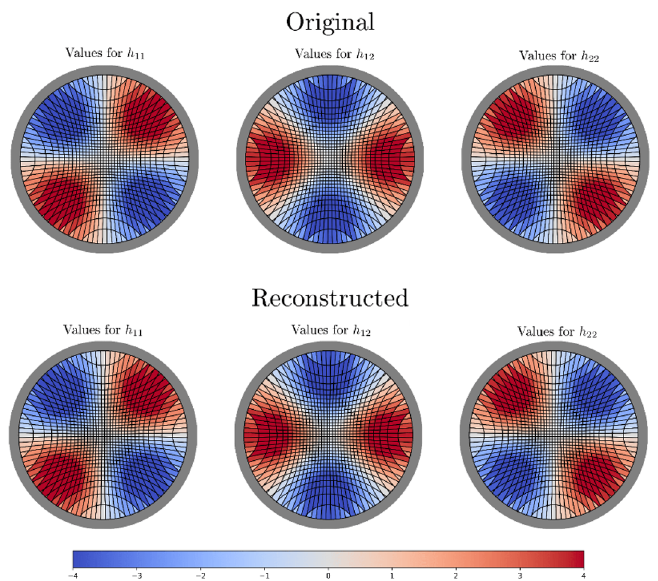
Figure 16. Top: Original bulk data generated with h 0 ( x, y ) = xy and h | C ( θ ) = sin(2 θ ) . Bottom: The bulk data reconstructed after running the forward Radon transform to get boundary data. Visually, the two sets of data are identical. The relative error between the two are E bulk ≈ 0 . 0227 (relative error 0 . 004643 without boundary